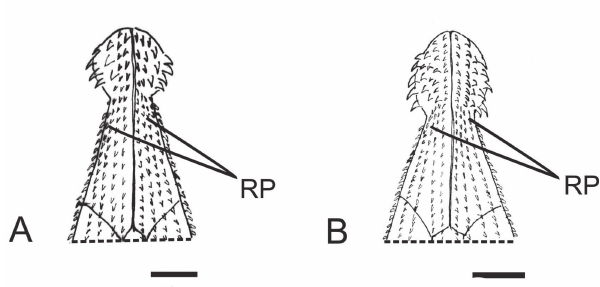
Fig. 2 . Spatulate projection of snout. A. Acestridium triplax ; B. Acestridium dichromum . RP: rostral plates. Scale: 1 mm.